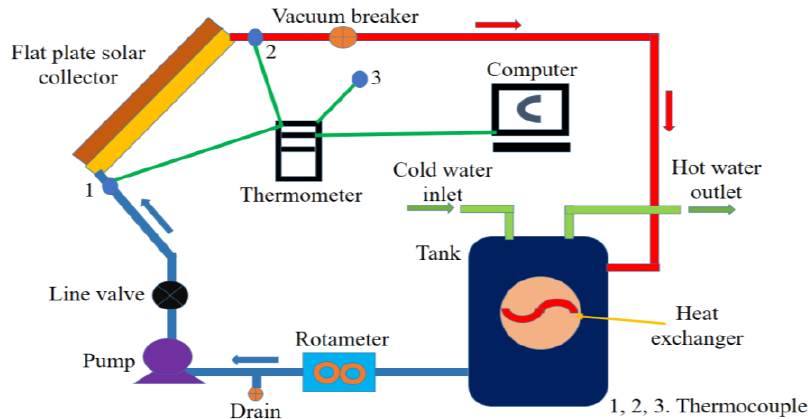
Fig. 4. The detailed schematic diagram of experimentations